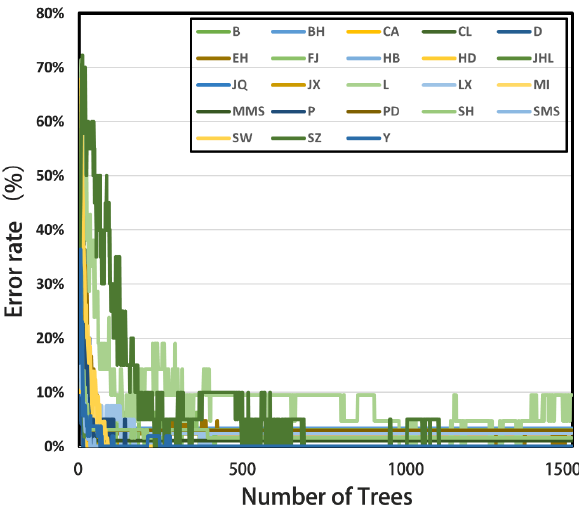
Figure 2. Correlation between the number of decision trees and out-of-bag (OOB) error rate in random forest model.The X-axis represents the number of decision trees used in the random forests, the Y-axis represents the out-of-bag (OOB) error rate, and the different colors in the legend indicate the 23 different pig breeds in this study.